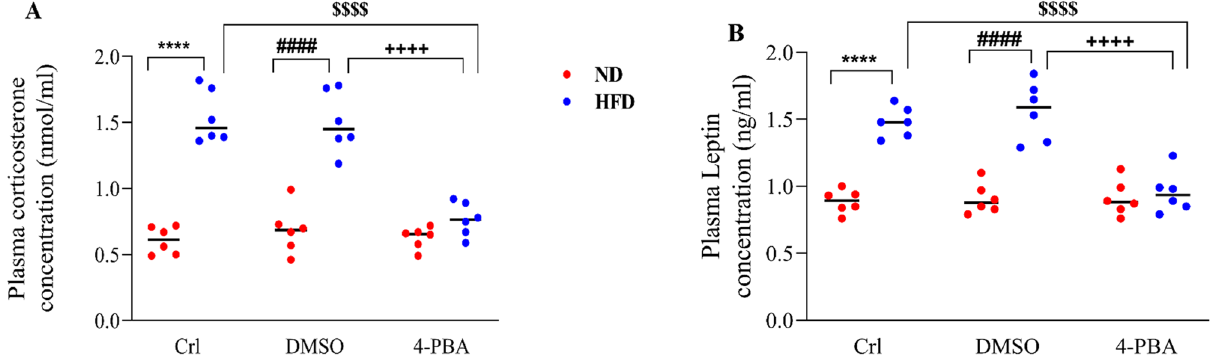
Figure 8. Effect of high-fat diet and/or 4-PBA on plasma ( A ) Corticosterone and ( B ) Leptin concentrations. Each point represents the mean ± SEM (6 rats/group). ****p < 0.0001 versus control of ND group, #### p < 0.0001 versus ND + DMSO group, $$$$ p < 0.0001 versus control of HFD group, ++++ p < 0.0001 versus HFD + DMSO group. ND Normal diet, HFD High-fat diet, Crl Control, DMSO Dimethyl Sulfoxide, 4-PBA 4-Phenyl Butyric Acid.